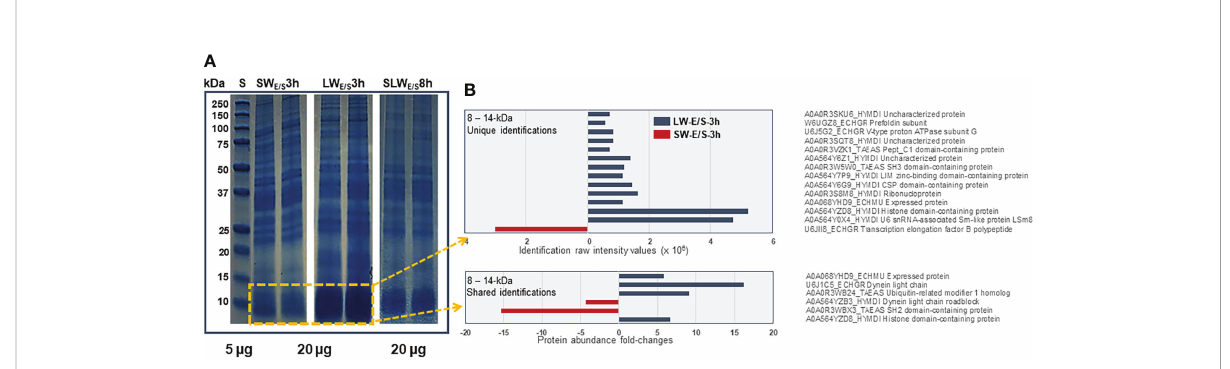
FIGURE 4 (A) Representative 1DE protein pro fi les of all E/S proteins produced by SWs and LWs at three-hour time point and SLWs after eight hours of incubation in vitro. Marker, protein standard (5 µg) with molecular weights between 250 – 10 kDa. (B) The most signi fi cant protein abundance fold-changes between the SWs- and LWs-associated E/S proteins migrating with molecular weights between 8 and 14 kDa.